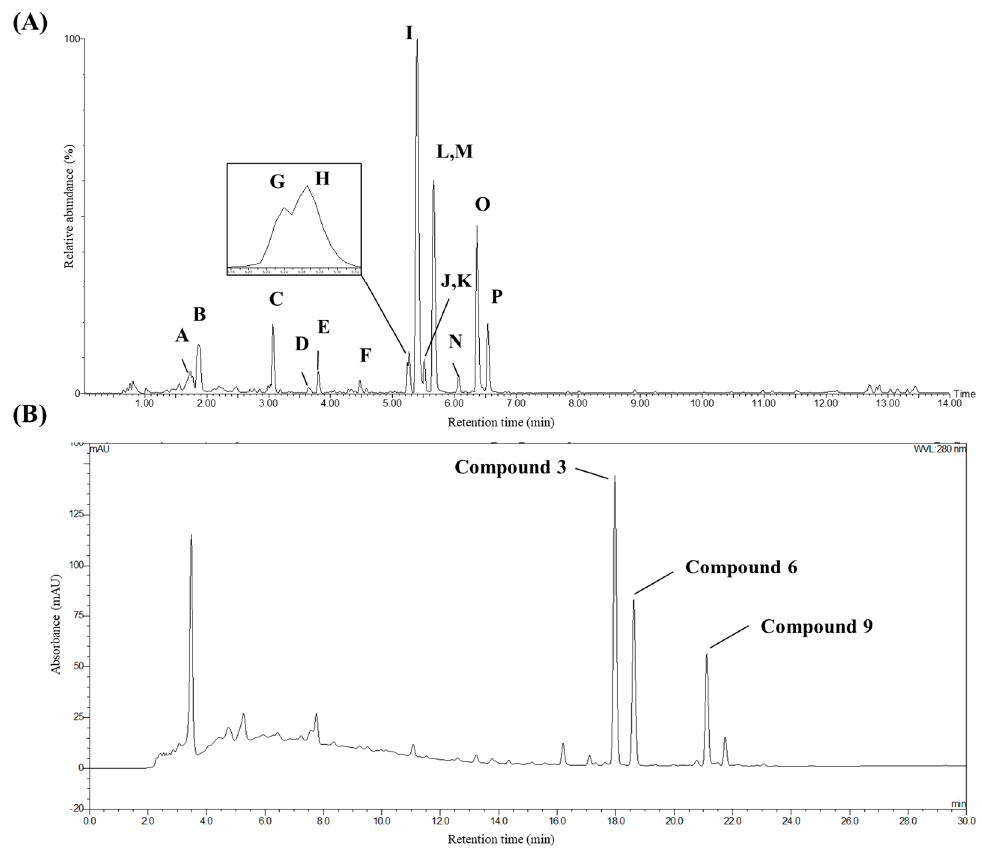
Figure 3. Base peak chromatogram ( A ) and HPLC-UV chromatogram ( B ) of ethanolic extract of I . lactea var . chinensis seeds.